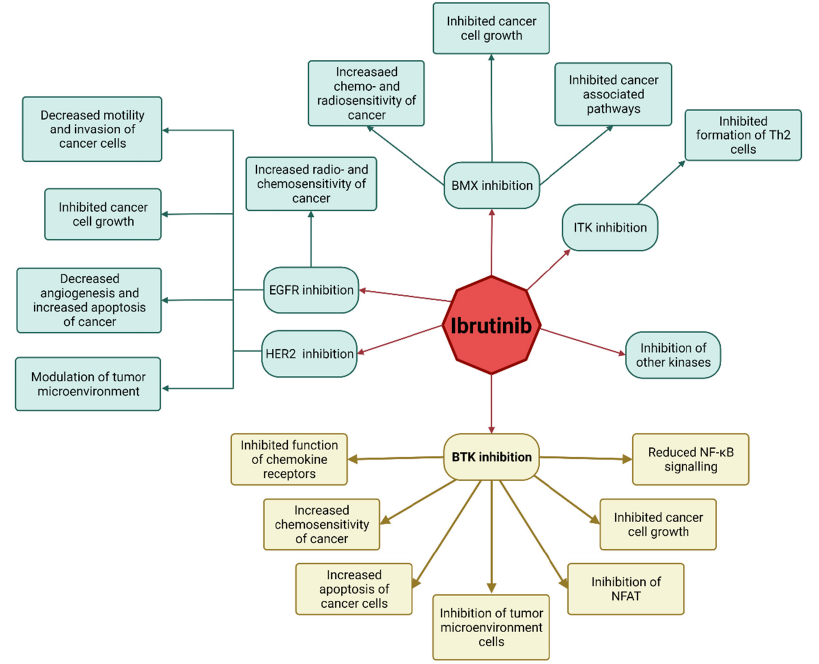
Figure 3. Ibrutinib as an anti-solid tumor drug. Ibrutinib exerts its action as an anti-solid tumor drug through its ability to inhibit both BTK and other cancer-associated kinases. In this figure, we focus on the kinases most relevant to the subject of this study: BMX, ITK, EGFR and HER2. BTK inhibition results in reduced NF- κ B signaling, decreasing the promotion and progression of cancer cells and a reduced function of CXCR4 and CXCR5, leading to reduced cancer’s ability to induce metastases and evade host immunity, decreased cancer cell growth, increased apoptosis and chemosensitivity of cancer cells through the inhibition of novel, oncogenic isoform of BTK present on the cancer cells. The inhibition of BTK expressing tumor microenvironment cells (MDSC, mast cells and monocytes) results in the decreased survival of cancer cells. Through the inhibition of ITK, it causes a limited activation of Th2 cells, subsequently increasing the number of anti-cancer Th1 cells due to their ex- pression of RLK, which is not expressed on Th2 cells [62,63]. The inhibition of BMX has been dis- covered to sensitize cancer to doxorubicin as well as chemo- and radiotherapy in prostate cancer; BMX-inhibition has been discovered to inhibit cancer cell growth in glioblastoma and to downreg- ulate the activation of PI3K/Akt, STAT and NF- κ B pathways [78]. Ibrutinib joins Cys797 residue of EGFR, thus inhibiting it, while HER2 inhibition occurs due to the key role of BTK in the AKT-ERK intracellular signaling. As a result, inhibition of EGFR and HER2 causes decreased angiogenesis, motility, invasion, and growth of cancer, while EGFR inhibition additionally increases the s radio- and chemosensitivity of cancer [48]. BTK, Bruton’s tyrosine kinase; EGFR, epidermal growth factor receptor; HER2, human epidermal growth factor receptor 2; ITK, Interleukin-2-inducible T-cell Ki- nase; JAK3, Janus kinase 3; NF- κ B, nuclear factor kappa-light-chain-enhancer of activated B-cells; NFAT, nuclear factor of activated T-cells. 3. Ibrutinib in Studies This section describes current published studies regarding ibrutinib in both preclini- cal studies and clinical trials. The stock of the results for each tumor discussed is repre- sented in Table 2.